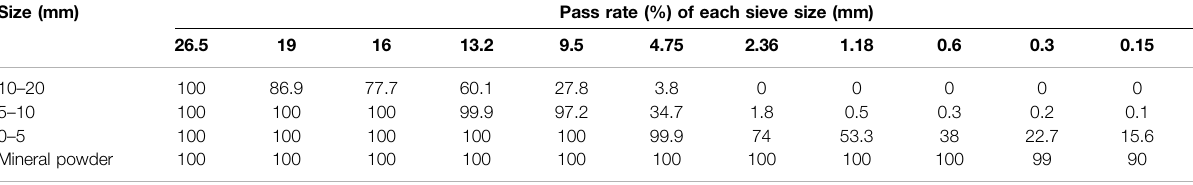
TABLE 2 | Particle composition of each grade of aggregate.